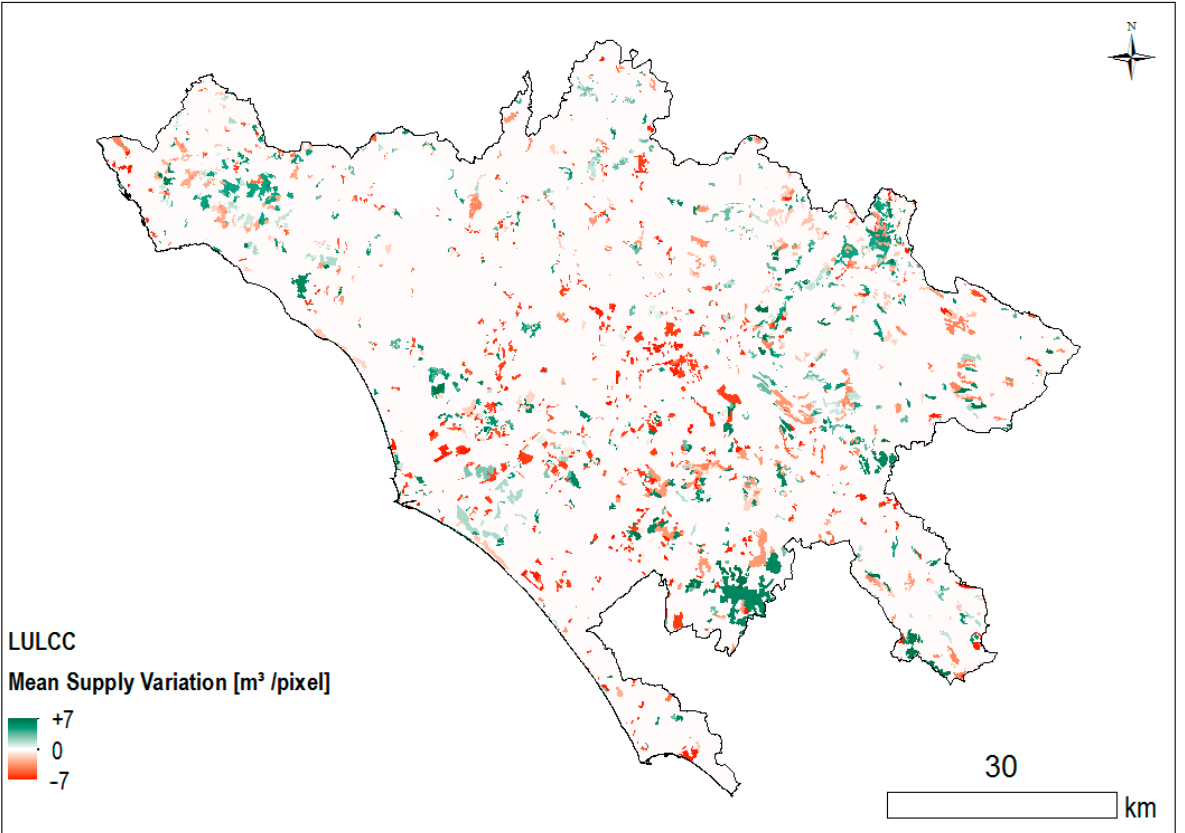
Figure 5. ES flood mitigation supply variation (1990–2018). This map represents the values of the ES supply variation at pixel level, obtained through the raster calculator tool. Gradations of red represent negative variations from the least pronounced (shaded red) to the most pronounced (full red), while gradations of green represent positive variations from the least pronounced (shaded green) to the most pronounced (full green).